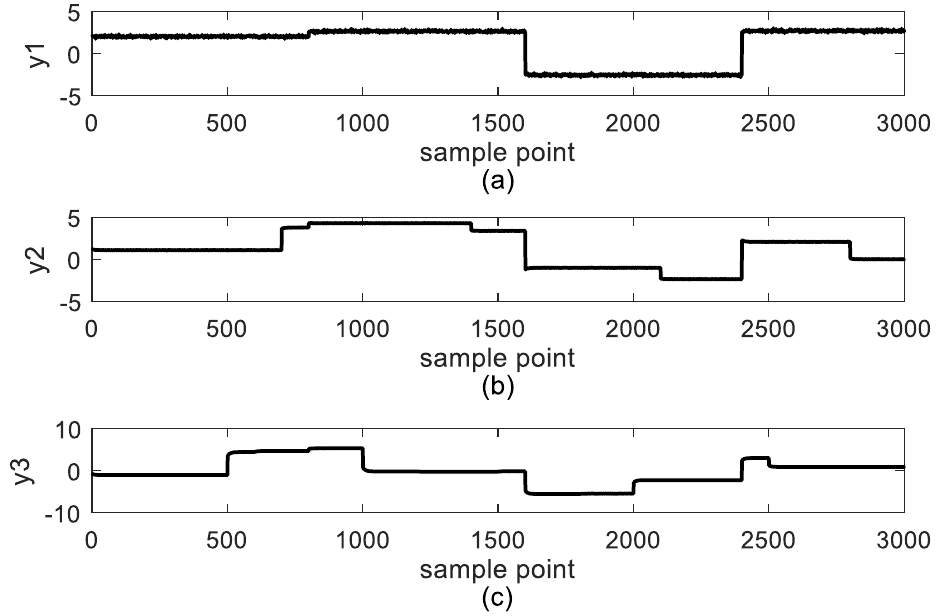
Figure 12. Output data of dynamic PLS model: ( a ) y 1 —production; ( b ) y 2 —slurry polymer; ( c ) y 3 —catalyst efficiency.